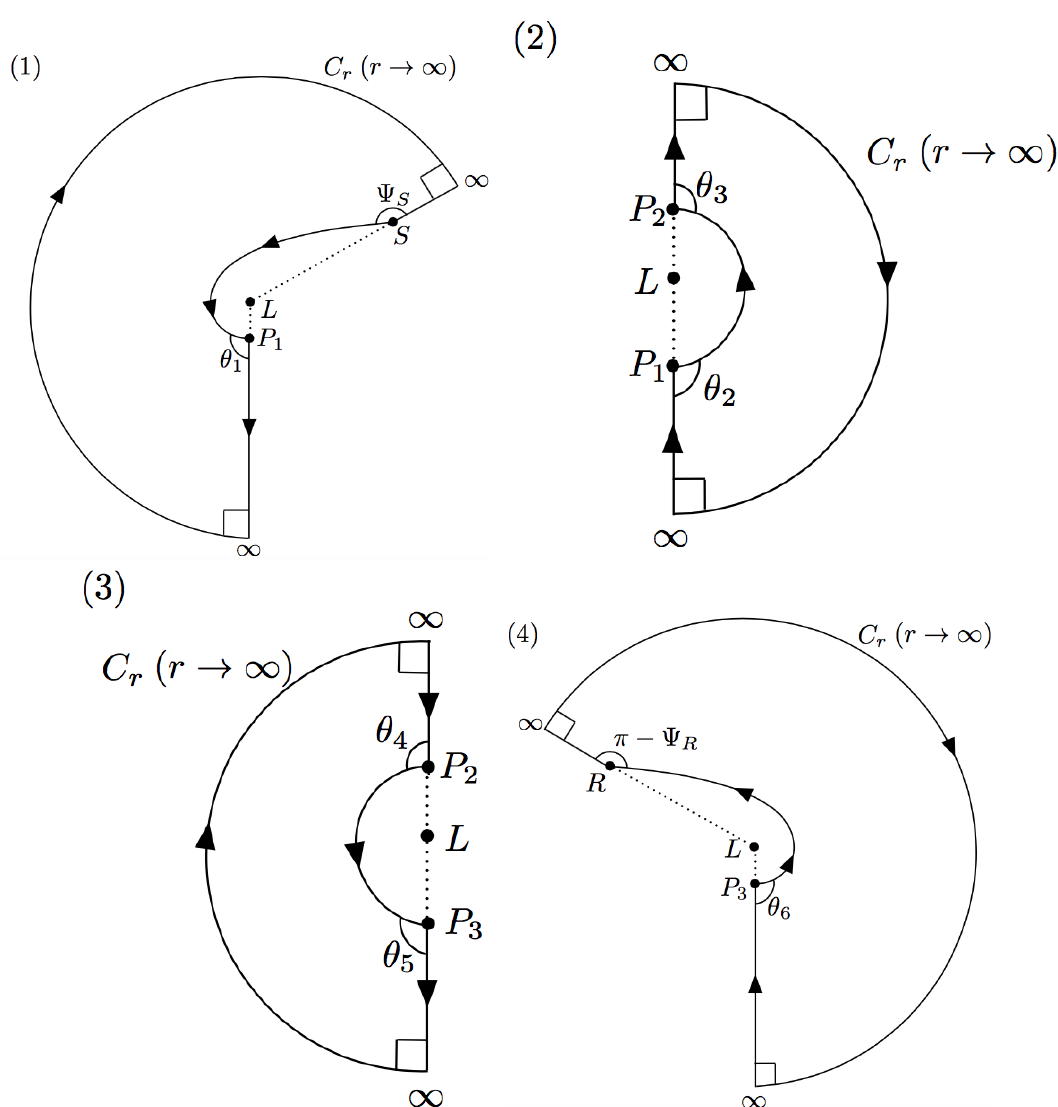
Figure 7. Quadrilaterals (1)–(4): They are in a non-Euclidean plane M opt . See also Figure